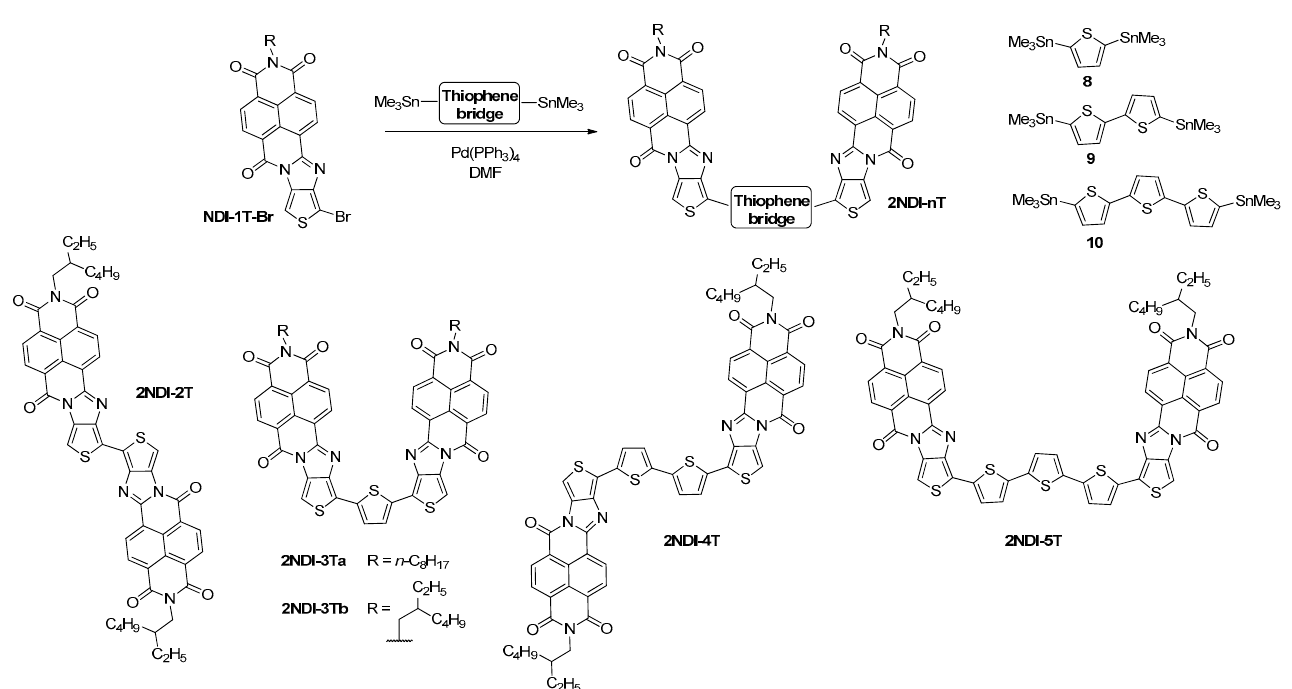
Scheme 4. Schematic representation of the reaction conditions ( top ) for the syntheses of the third generation of oligothiophene–naphthalimide assemblies ( bottom ).